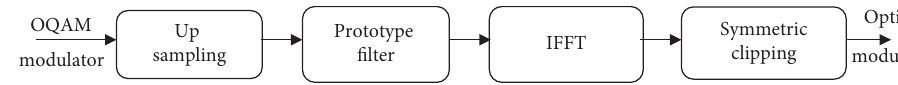
Figure 2: Block diagram of the ACO-FBMC